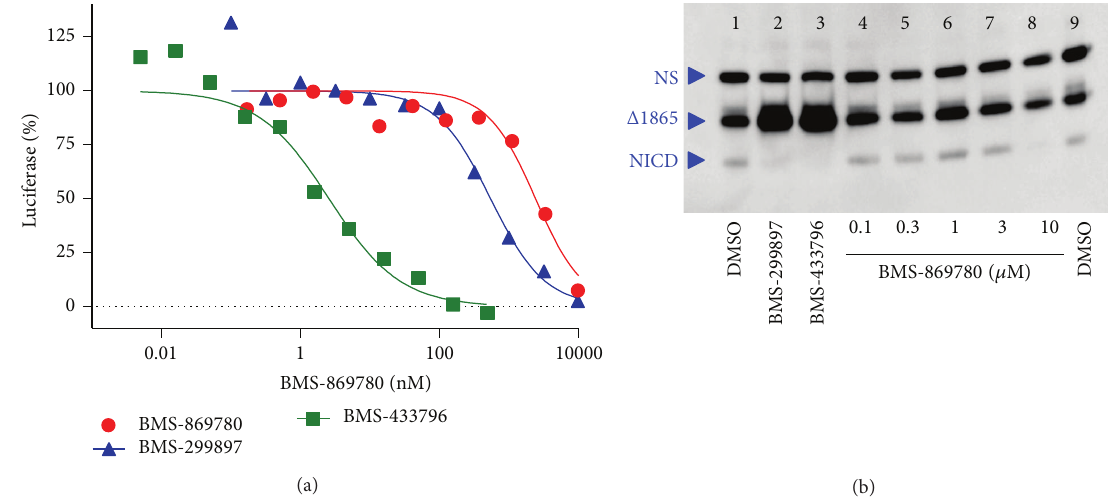
Figure 6: BMS-869780 did not inhibit Notch cleavage in vitro . (a) HeLa cell cultures were transfected with mNotch Δ E and CBF1-luciferase reporter constructs, treated overnight with BMS-869780 ( e ), BMS-299897 ( 󳵳 ), or BMS-433796 ( ◼ ), and luciferase assays were carried out. (b) HeLa cell cultures were transfected with mNotch Δ 1865, treated with compounds overnight, and cell extracts were evaluated by western blot using anti-c-myc-HRP conjugate. Lanes 1 and 9: DMSO (0.1%) vehicle. Lane 2: BMS-299897 at 1 𝜇 M. Lane 3: BMS-433796 at 0.3 𝜇 M. Lanes 4–8: BMS-869780 at 0.1, 0.3, 1, 3, and 10 𝜇 M, respectively.